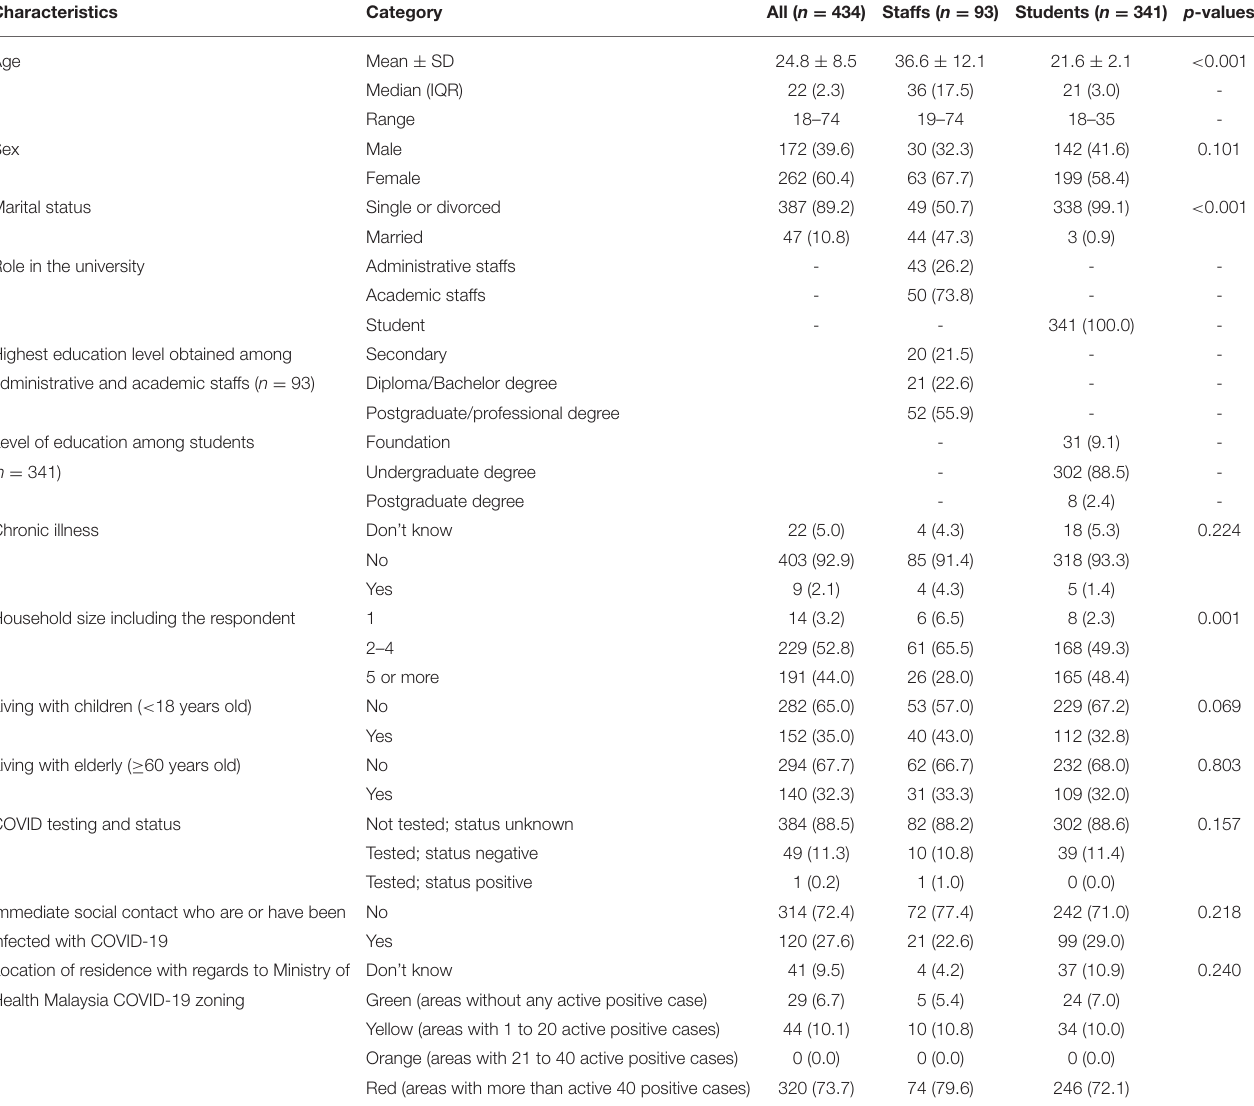
TABLE 1 | Socio-demographic characteristics of respondents ( n = 434).